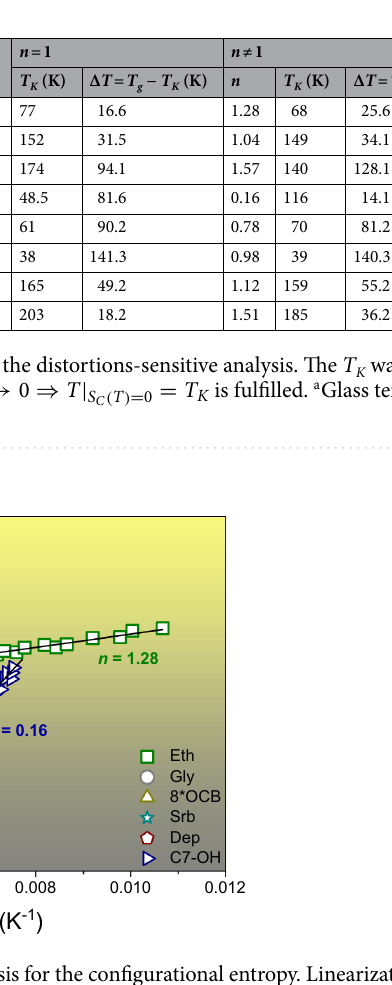
Figure 2. Distortions-sensitive analysis for the configurational entropy. Linearization S C ( 1 / T ) = A + Bx , where A = 1 / nT K , B = 1 / n Eq. (15). All calculated parameters n corresponds well with ones obtained using Eq. (10) (see Table